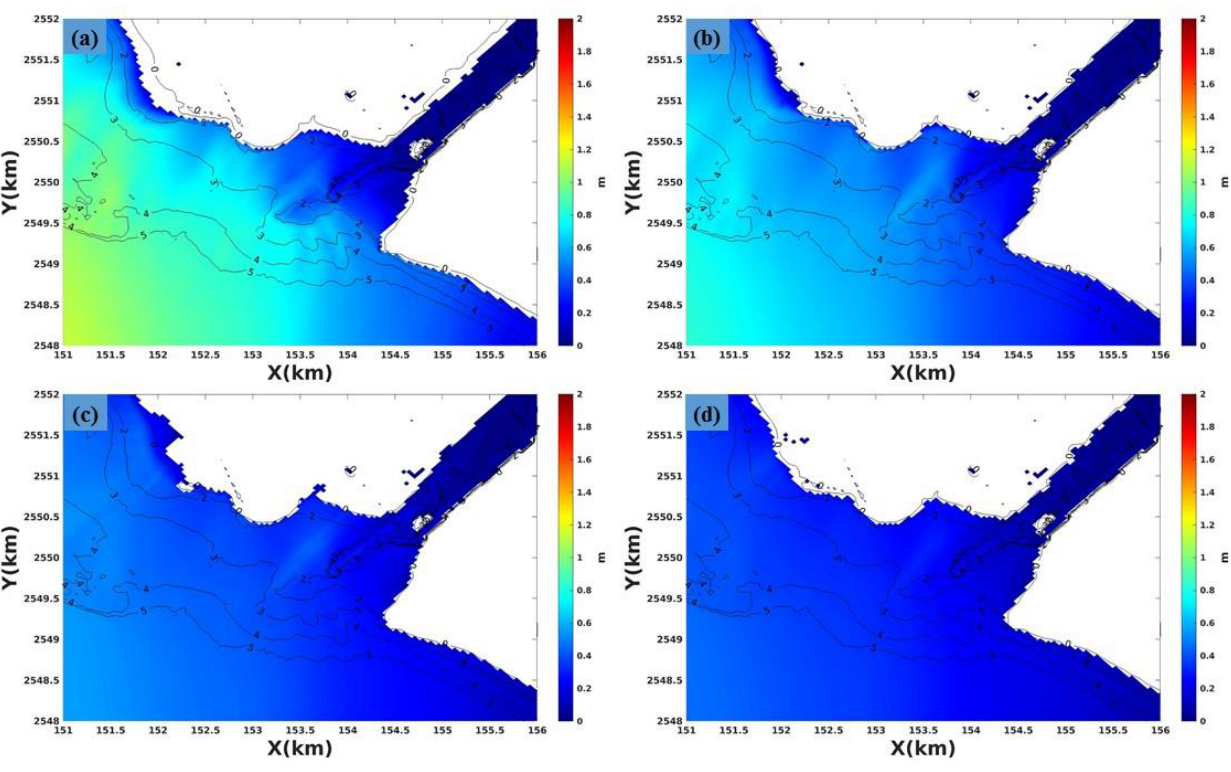
Figure 8. The simulated significant wave heights during different tidal hours under the condition of ( a ) the maximum ebb with energetic waves, ( b ) flood tides with moderate waves, ( c ) the maximum flood tide with mild waves, and ( d ) ebb tide with mild waves (color: significant wave heights, scale on the right, contour: depth).